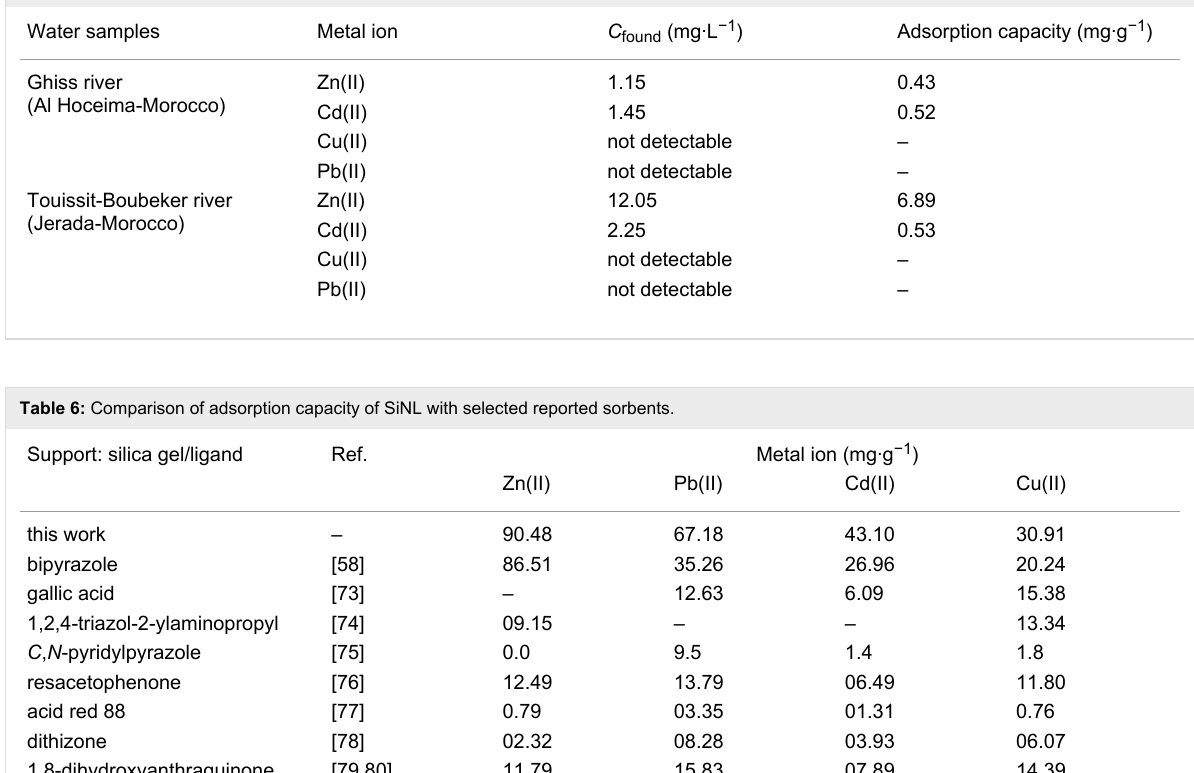
Table 5: Extraction of heavy metal in natural real water samples.